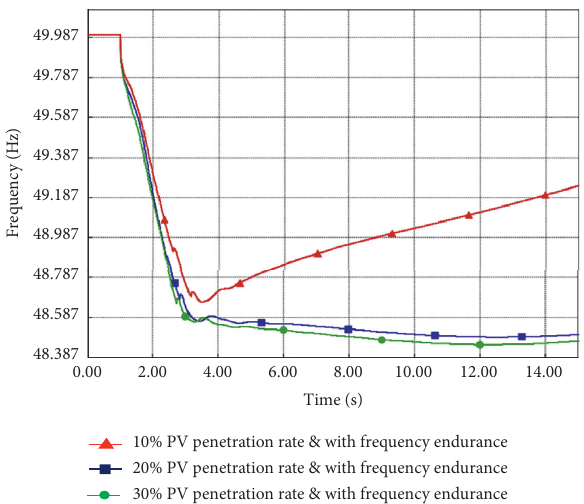
Figure 8: Frequency response of the power system with 15% the distributed photovoltaic generation with frequency endurance capability under different